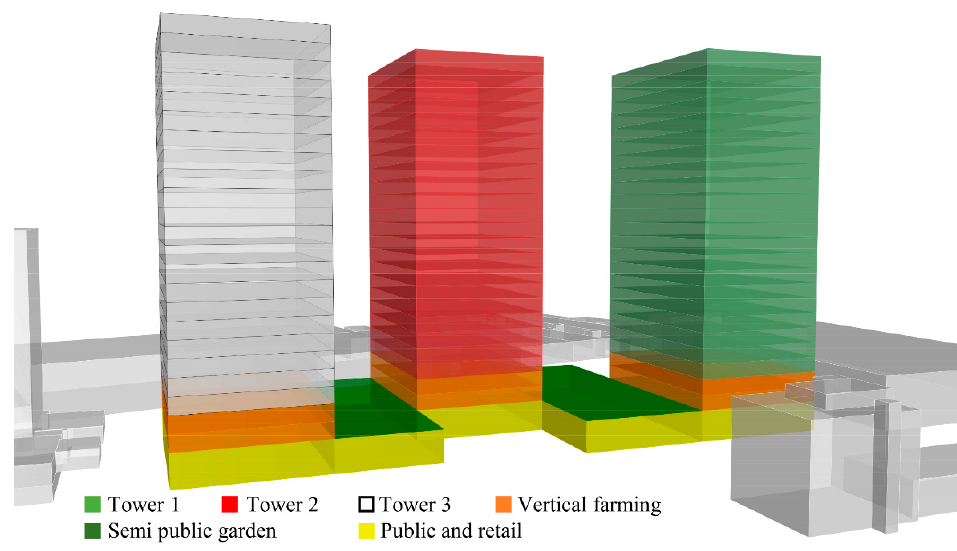
Figure 3. Proposed building program.